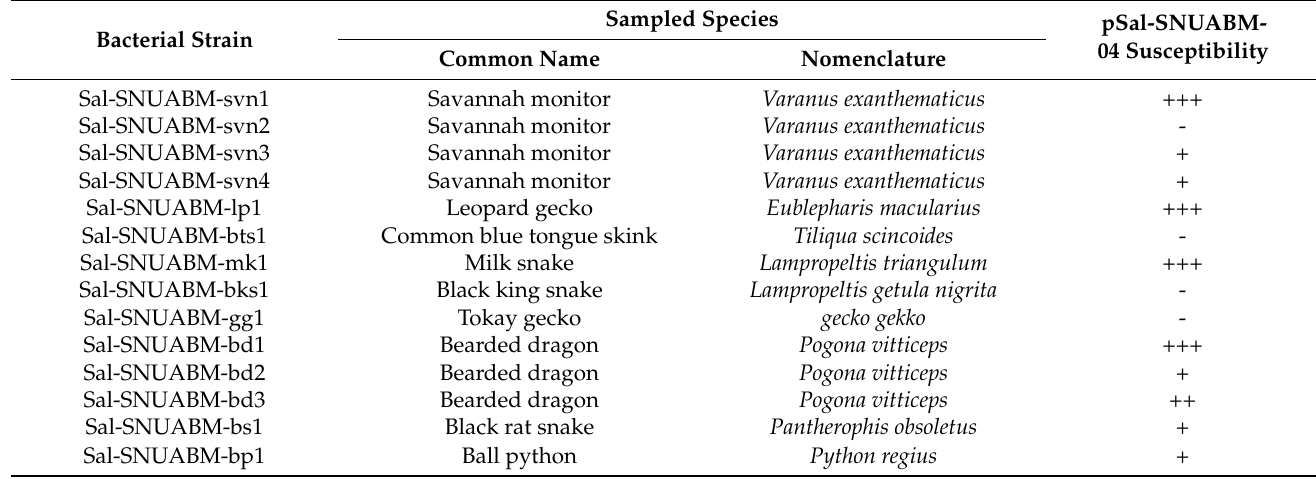
Table 1. Bacterial strains and bacterial susceptibility to pSal-SNUABM-04. − , plaque not formed; +, turbid plaque formation; ++, clear plaque formation; +++, more clear plaque formation. Bacterial Strain